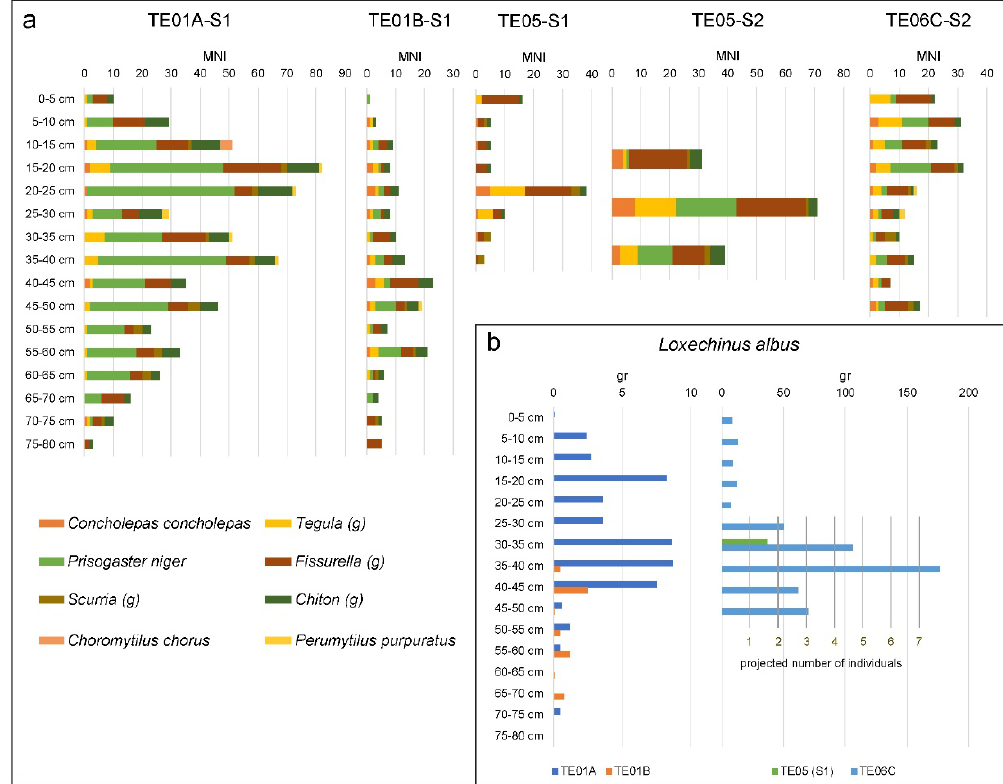
Figure 5. Malacological assemblages of the studied sites: ( a ) MNI of the main taxa of the malacological assemblages of the La Cebada (TE01A, TE01B), Las Corvinas 2 (TE05) and Quebrada San Pedro Norte (TE06) sites; (g) genus with more than one species; S: sample; ( b ) mass of Loxechinus albus (gr) and projected MNI represented in the assemblages, divided between samples with less than one individual per level and samples with more than one individual per level.